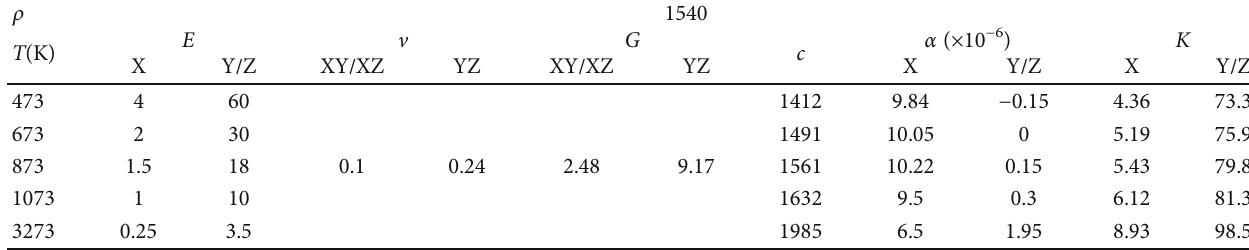
Table 1: Material properties of C/C composite.